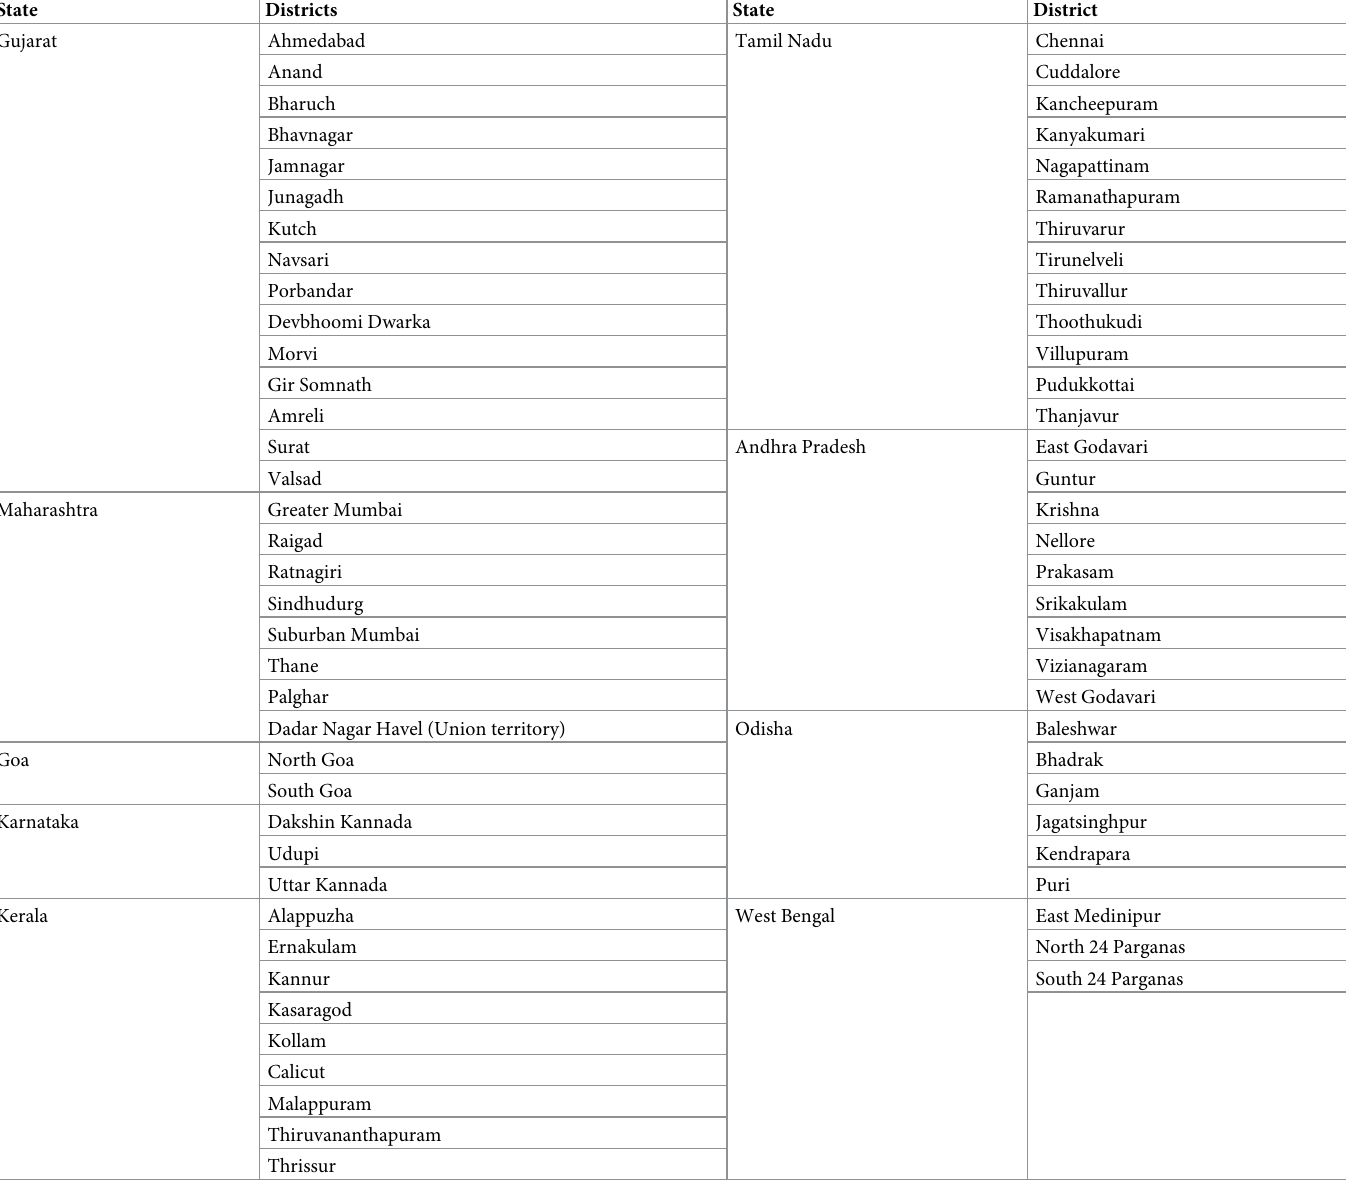
Table 1. Coastal districts of various states in India.